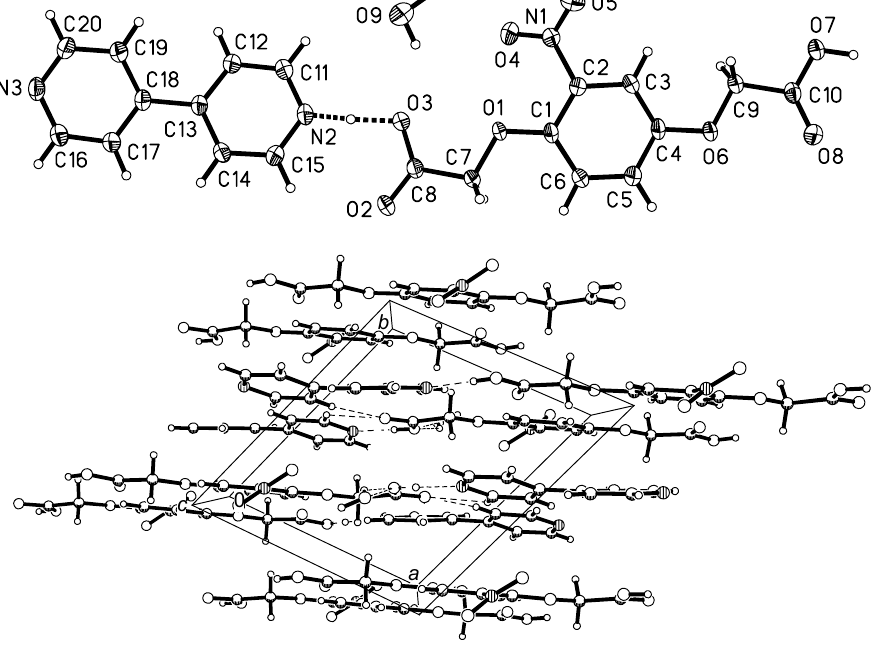
Theasymmetricunitofthetitlecrystalstructureconsistsofone2- nitro-benzene-1,4-dioxyacetic acid, one 4,4 (cid:4) -bipyridine and one water molecule (figure, top). The bond lengths and angles of 2- nitro-benzene-1,4-dioxyacetic acid are similar to those of free 2- nitro-benzene-1,4-dioxyaceticacid[5],andO1,O6andN1atoms are almost co-planar to the benzene ring. There are two kinds of hydrogen bond interactions between the adjacent 2-nitro-benzene- 1,4-dioxyacetic acid and bipyridine molecules (O7H7O···N3